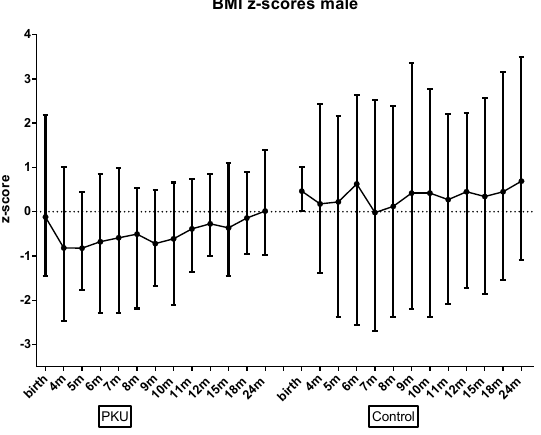
Figure 2. Mean male BMI z-scores for PKU vs. control groups by